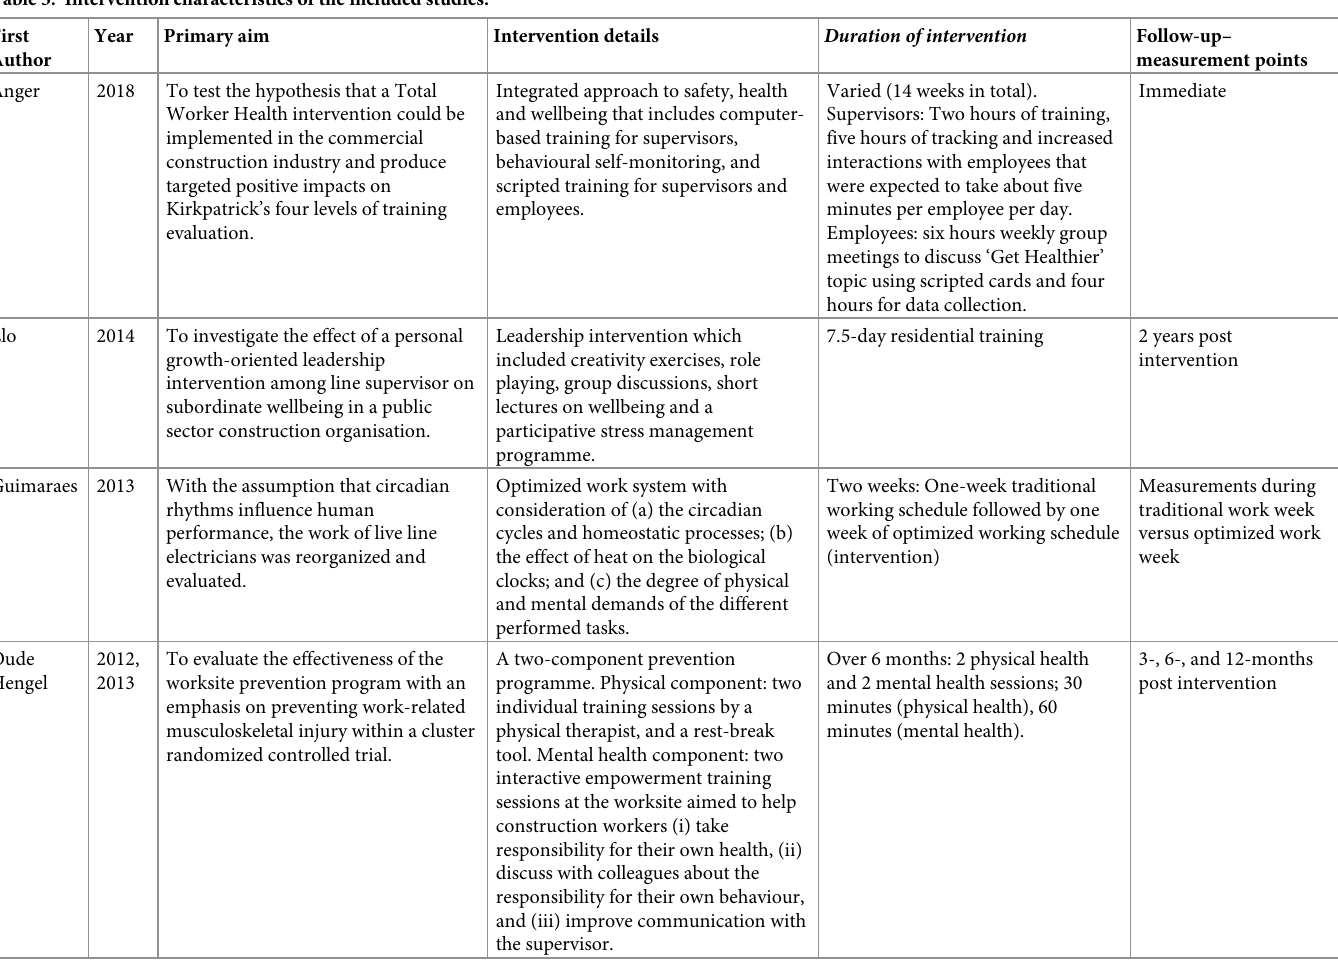
Table 3. Intervention characteristics of the included